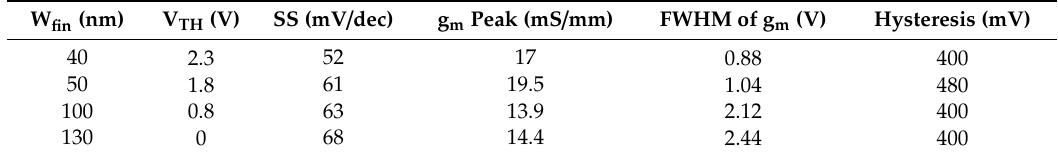
Figure 4. Sloped sidewall MIS-FinFETs with 10 nm-thick Al 2 O 3 gate dielectric varying the W fin from 130 to 40 nm. ( a ) Logarithmic transfer curves; ( b ) Linear transfer curves; ( c ) Transconductance curves. Table 3. Key parameters for each device exhibited in Figure 4.